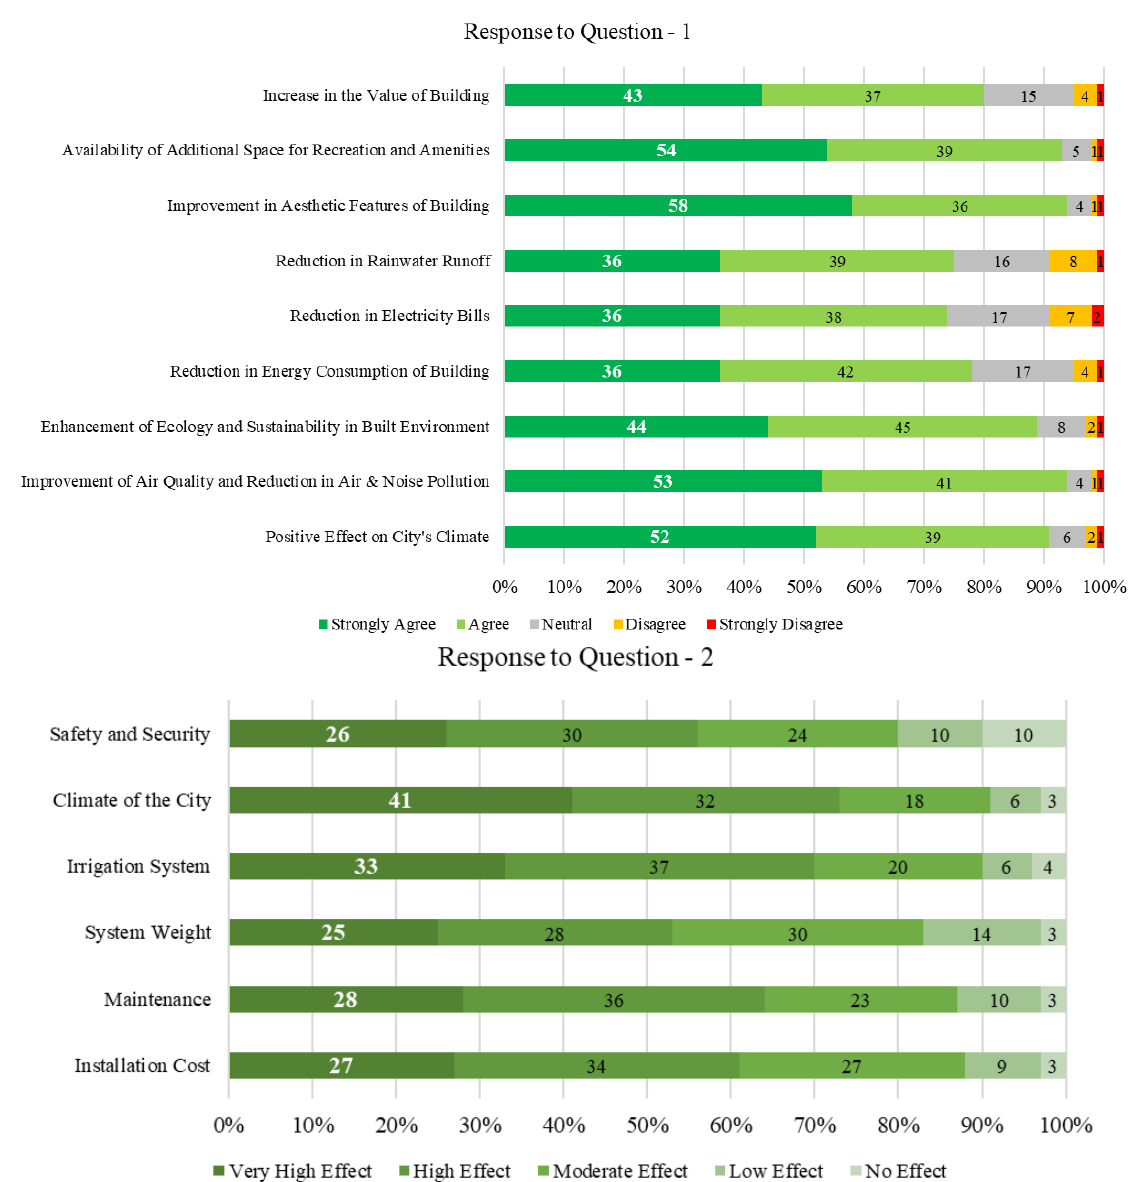
Figure 7. Response percentages for survey Questions 1 and 2.